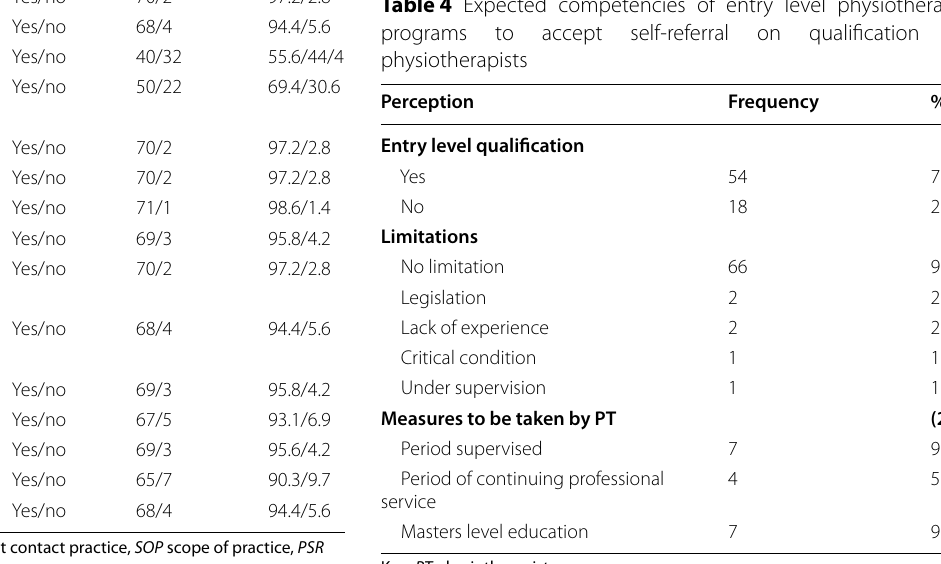
Table 4 Expected competencies of entry level